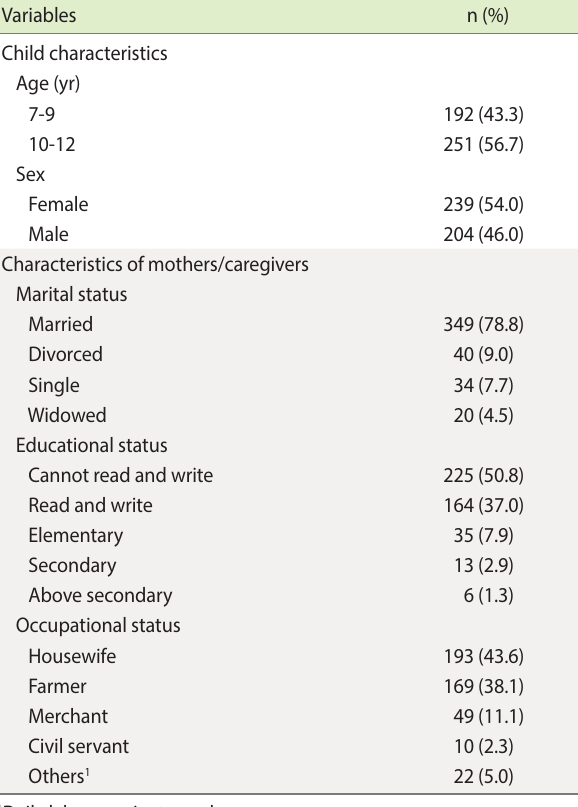
Table 1. Socio-demographic characteristics of children and their mothers/caregivers in Gasgibla woreda , Waghimra Zone, northeast Ethiopia, 2015